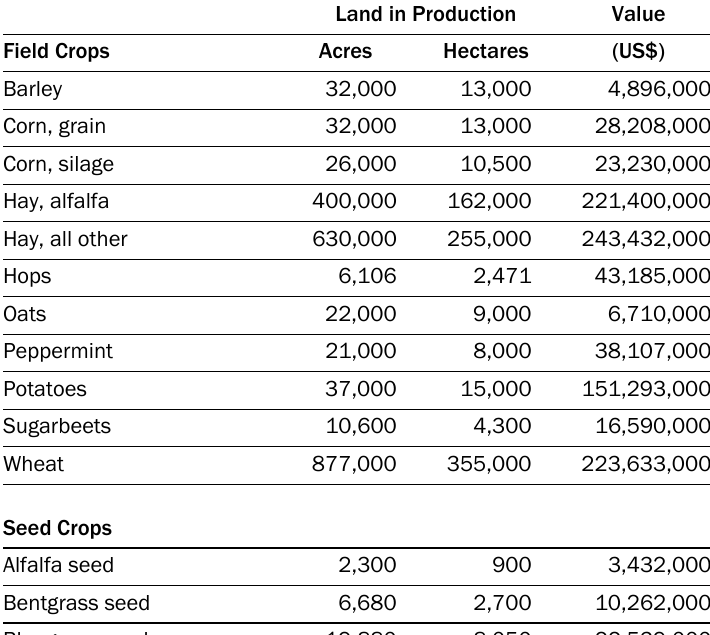
Table 1. Willamette Valley, Oregon 2009 Field Crop Data by Acreage and Value (all values in US$) Land in